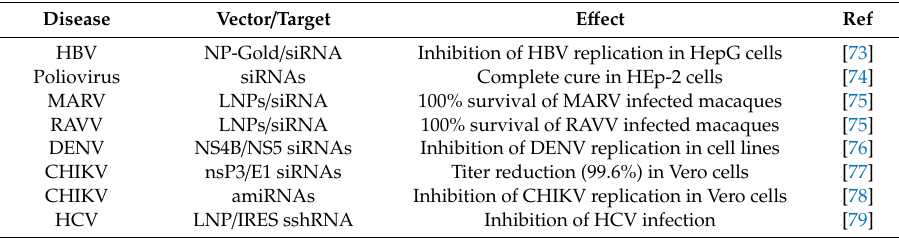
Table 2. Examples of non-viral vector-based